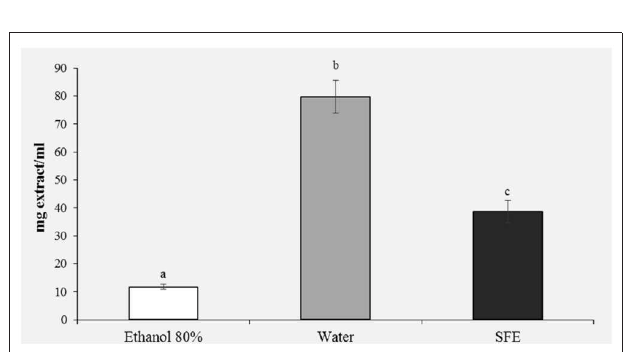
FIGURE 4 | Reducing power (EC50, mg/ml) of honey bee pollen (HBP) extracts obtained with different solvents. Lowercase letters indicate significant differences between different solvents (a, b, c: P <